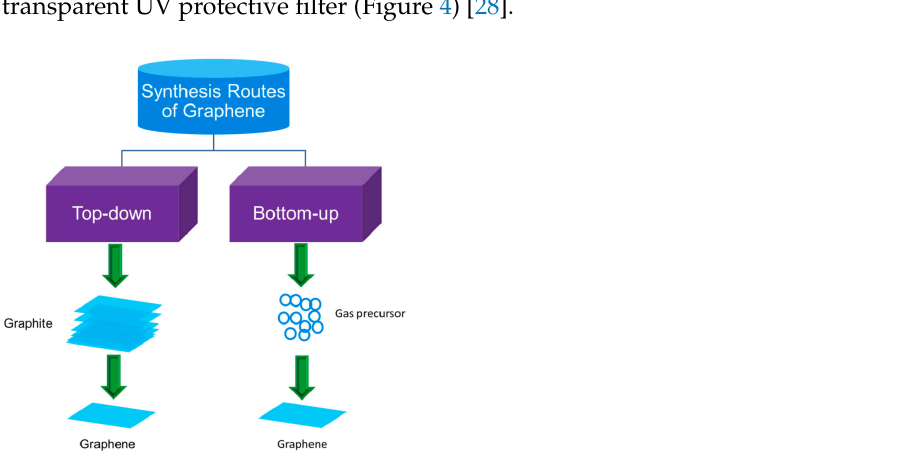
Figure 1. Schematic diagram representing the synthesis routes of graphene. Reproduced with permission [28]. Copyright 2021, Elsevier.